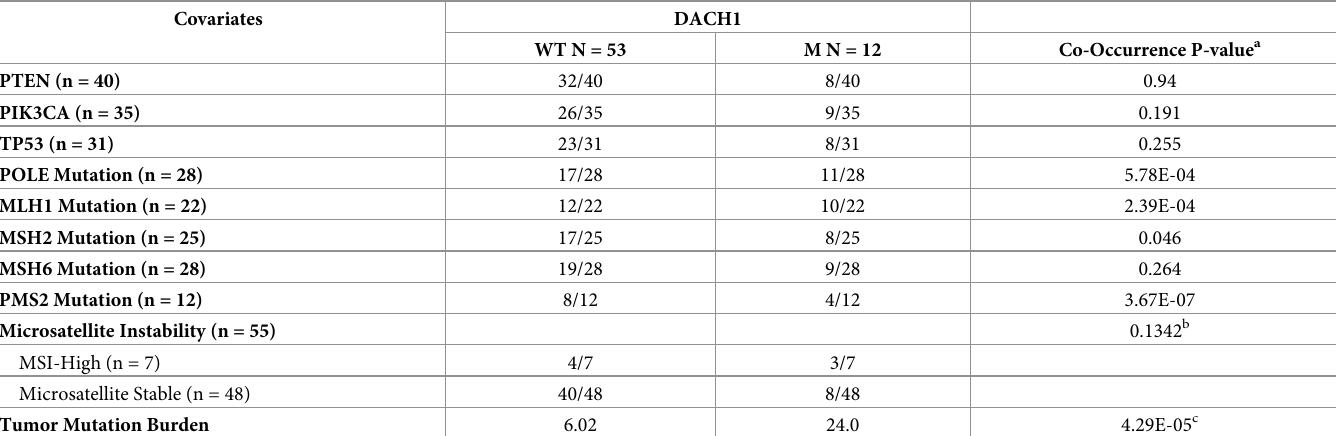
Table 4. Genomic covariate analysis of DACH1 mutated patients compared to wild-type at MCC (n = 65